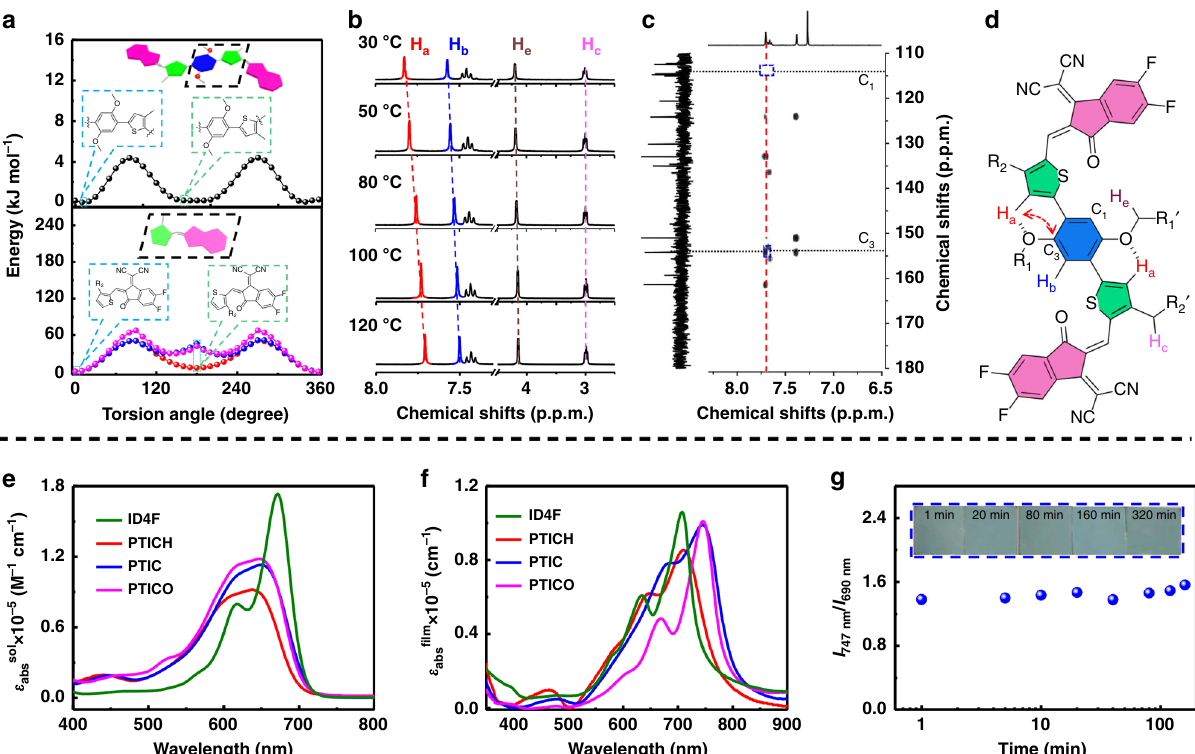
Fig. 2 Molecular conformation and optical properties. a Possible rotamers and their energy – torsion angle ( E – θ ) curves: black curve for PT rotamer (left structure for O – H geometry and O – S geometry at the right); TICH rotamer (red), TIC rotamer (blue), and TICO rotamer (pink). b Temperature-dependent NMR of PTIC in d 4 -C 6 D 4 Cl 2 . c The heteronuclear multiple-bond correlation (HMBC) of PTIC in CDCl 3 . d The preferential conformation of PTIC. e The solution and f fi lm UV – vis absorption of ID4F and NFRAs. g The UV – vis absorption of I 747nm / I 690nm ratio for PTIC fi lm annealed at 100 o C for 320 min,